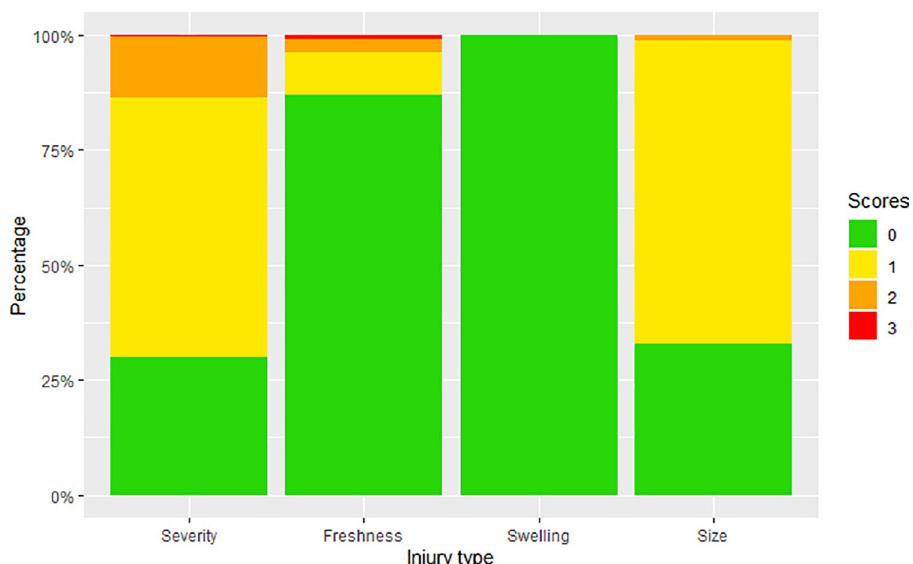
Fig 3. Stacked bar graph of frequency of ear injury scores. Severity (0, 30.0%; 1, 56.4%; 2, 13.4%; 3, 0.2%), freshness (0, 86.9%; 1, 9.2%; 2, 3.0%; 3, 0.9%; 4, 0.0%), swelling (0, 99.8%; 1, 0.1%; 2, 0.1%) and size (0, 32.8%; 1, 66.8%; 2, 1.2%; 3, 0.0%) of ear injury are shown. (See S1 File for score descriptions).